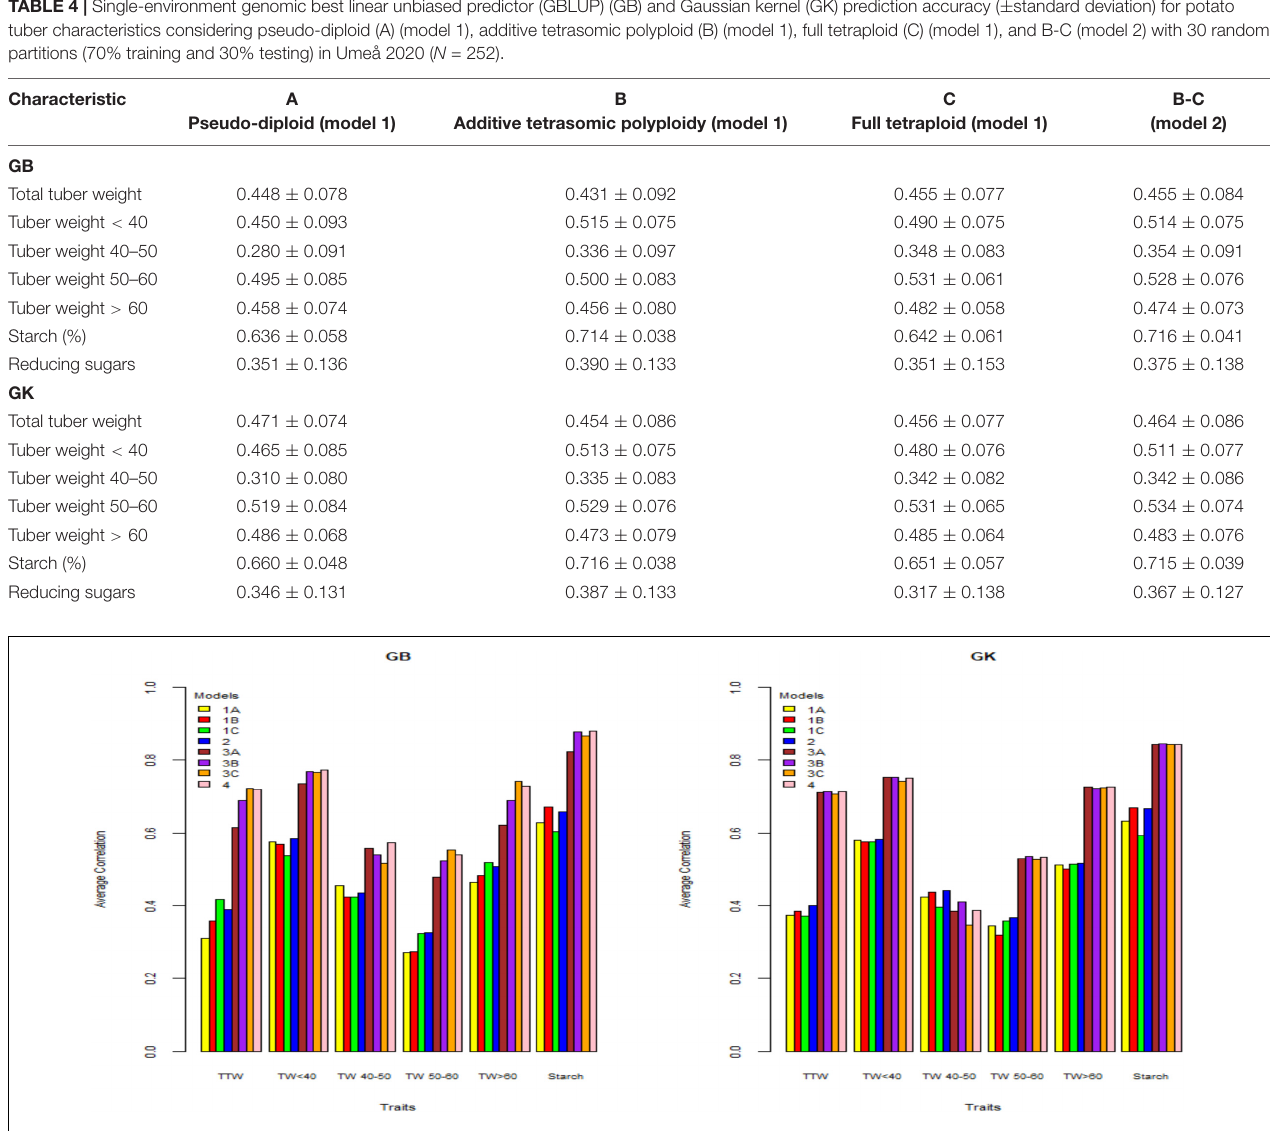
FIGURE 1 | Genome-based predictions (average correlation between observed and predicted values) of potato breeding clones and cultivars in Helgegärden site for total tuber weight (TTW), tuber weight with size below 40 mm (TW < 40), tuber weight with 40–50 mm size (TW 40–50), tuber weight with 50–60 mm size (TW 50–60), tuber weight above 60 mm size (TW > 60), and tuber starch percentage (Starch) considering single environment pseudo-diploid (A) (model 1) (1A), additive tetrasomic polyploid (B) (model 1) (1B), full tetraploid (C) (model 1) (1C), and B-C (model 2) (2) and multi-environment pseudo-diploid (A) (model 3) (3A),